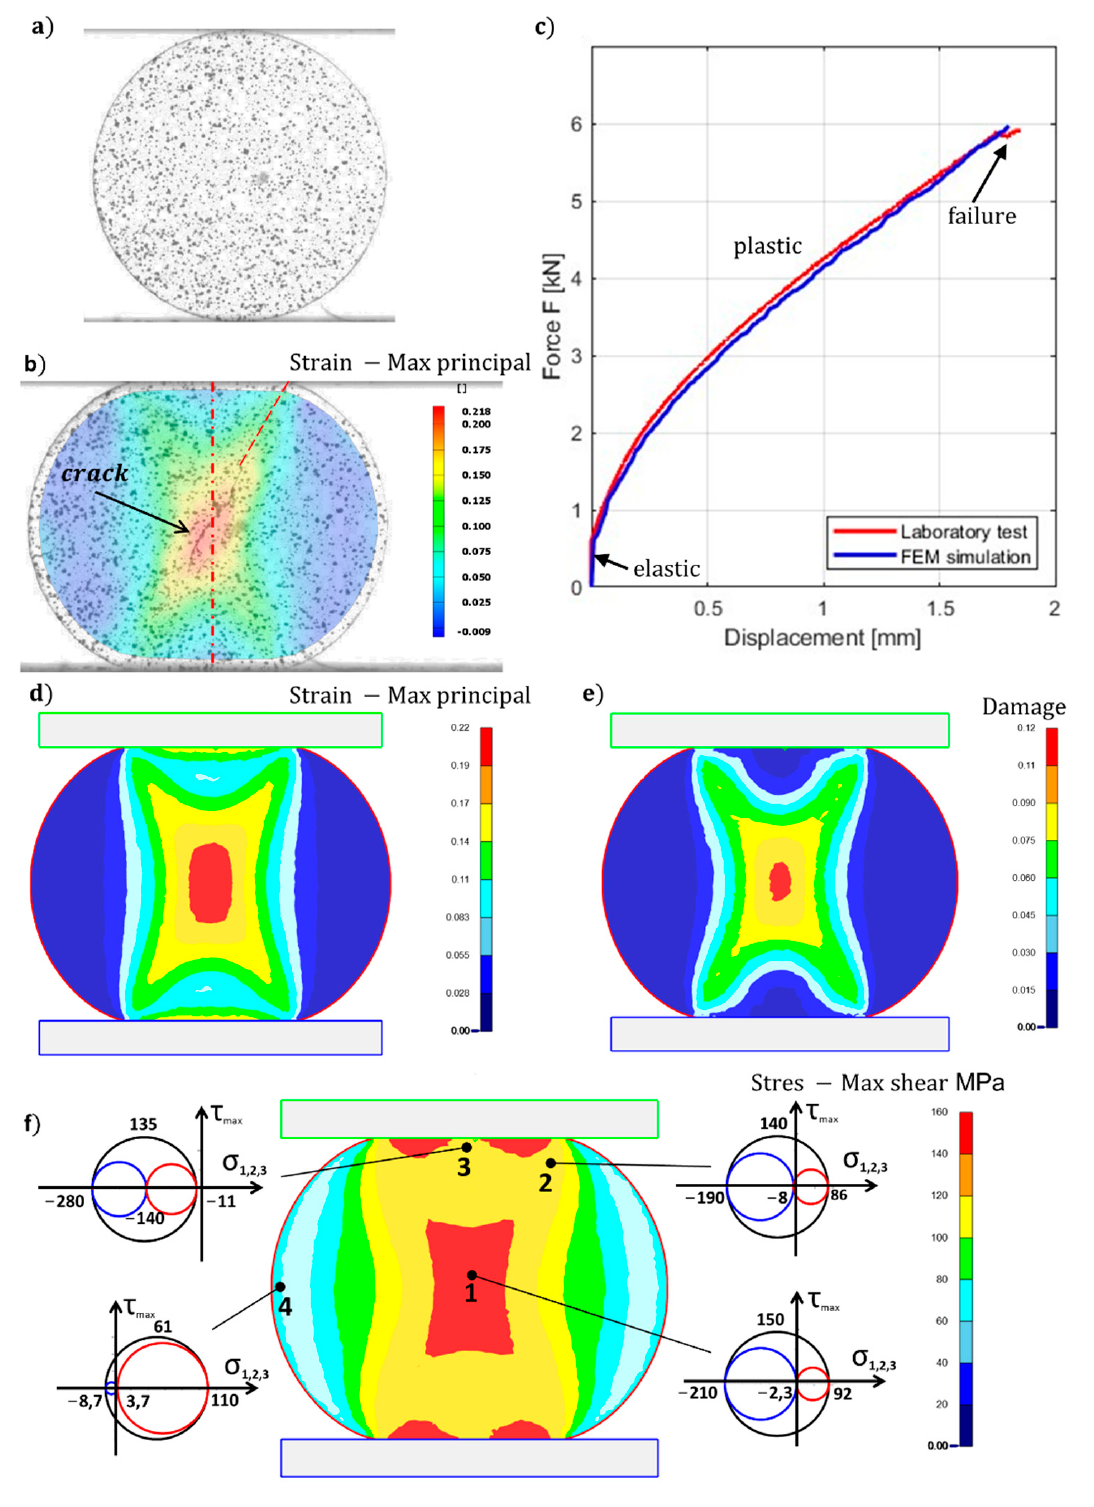
Figure 4. The diametrical compression test: ( a ) sample before the DC test with the pattern; ( b ) sample after the DC test with the pattern and distribution of principal strain ( ϕ 1 ) using DIC analyses; ( c ) force comparison between FEM simulation and laboratory DC test; ( d – f ) distribution of the principal strain ( ϕ 1 FEM ), the damage factor and max. shear stress ( τ max ) from FEM simulation (displayed in the plane xy), respectively.